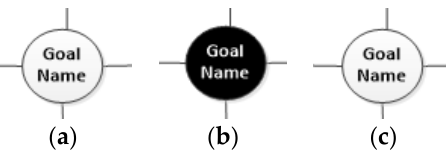
Figure 7. Visual representation of security goal and impact of threat on goal in the BPMN extension. ( a ) security goal symbol, ( b ) high threat of impact on goal, ( c ) low impact of threat on goal. 4. Representation Rules in BPMN 2.0.2